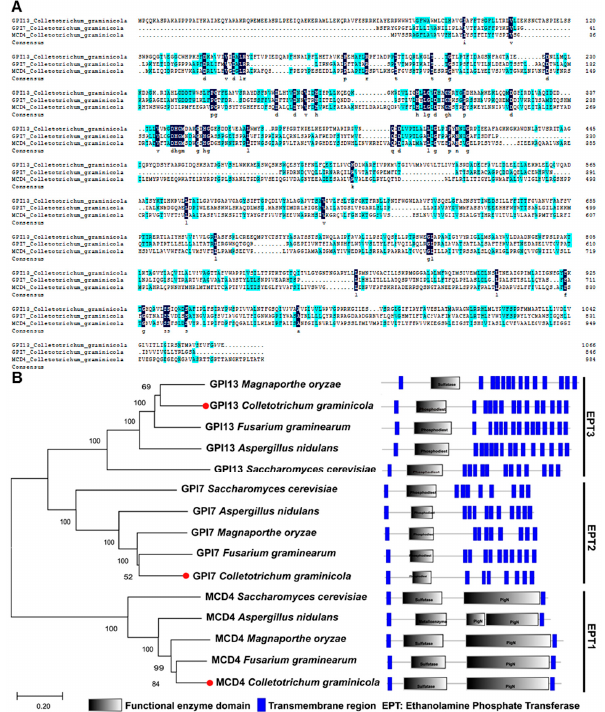
Figure 1. Phylogenetic analysis of GPI ethanolamine phosphate transferase family proteins. ( A ) Multiple alignments of ethanolamine phosphate transferases CgGPI13, CgGPI7, and CgMCD4 in C. graminicola . Total sequence identity was 21.06%. ( B ) Phylogenetic tree of GPI ethanolamine phosphate transferases from different fungal species. EPT, ethanolamine phosphate transferase.